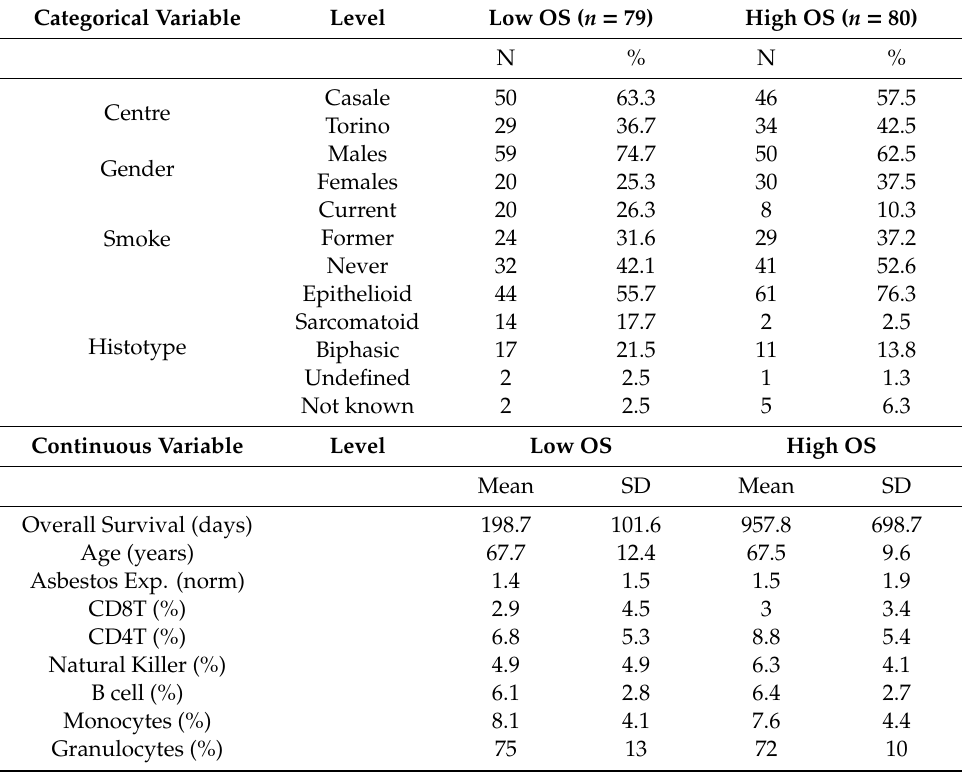
Table 2. Descriptive information of MPM patients. Median survival (365 days) was used as cut-o ff value to stratify patients in high and low